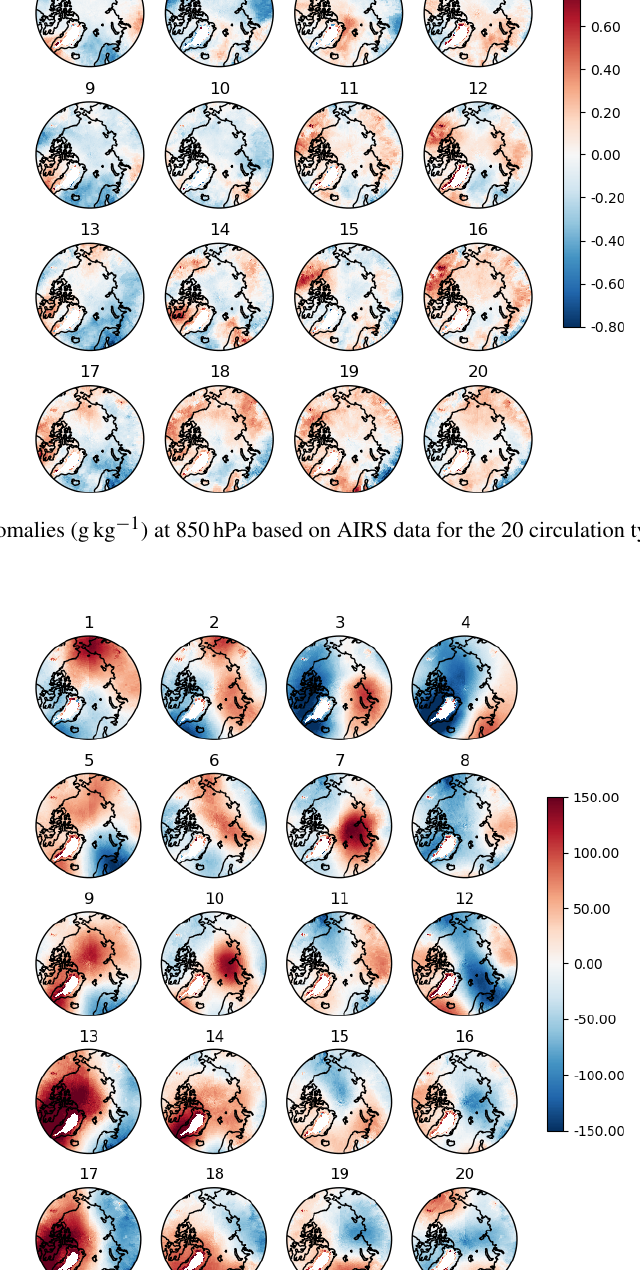
Atmos. Chem. Phys., 21, 16593–16608,